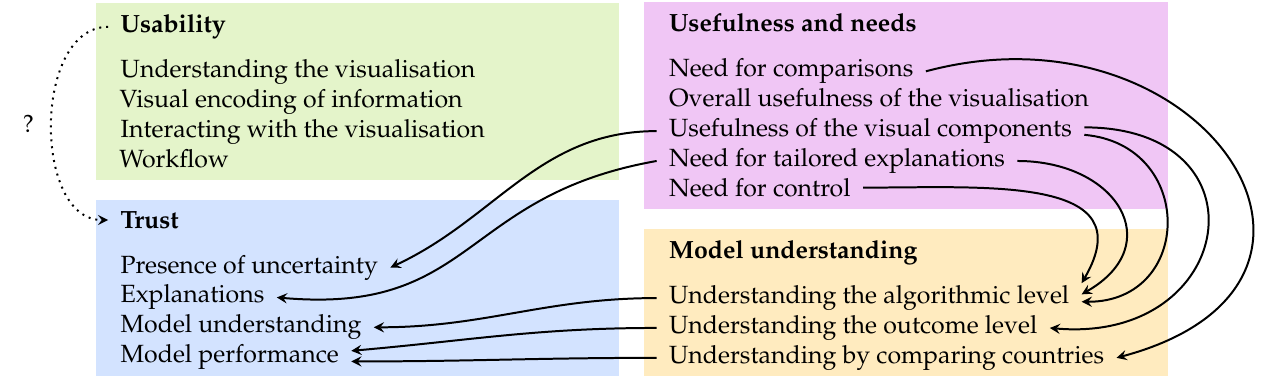
Figure 5. Summary of the themes on usability, usefulness and needs, model understanding, and trust. Some relations between themes are indicated with arrows; themes are reordered to avoid